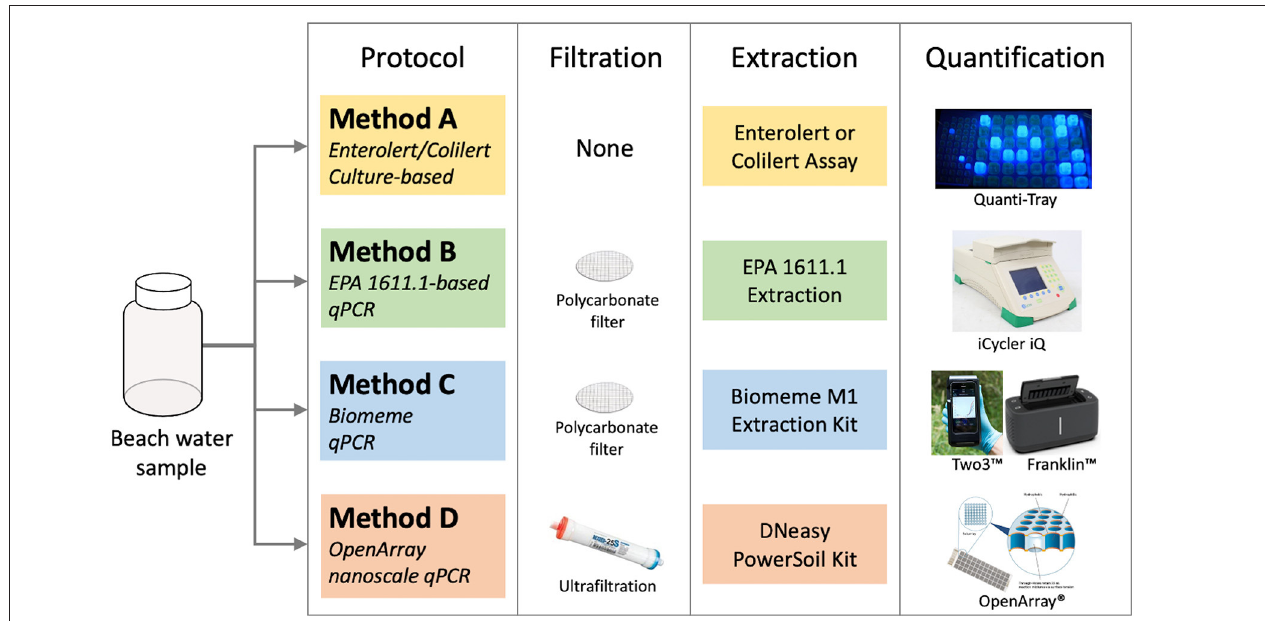
FIGURE 1 | Schematic of the culture-based (Method A) and qPCR-based protocols (Methods B–D) show the workflow from raw beach water samples to comparable results. Method A (Enterolert or Colilert) is the standard method used by NYS beaches. Method C includes four qPCR variants (C1, C2, C2-IPC, and C3). Details on the qPCR assays and which methods were conducted in each year are described in Table 1